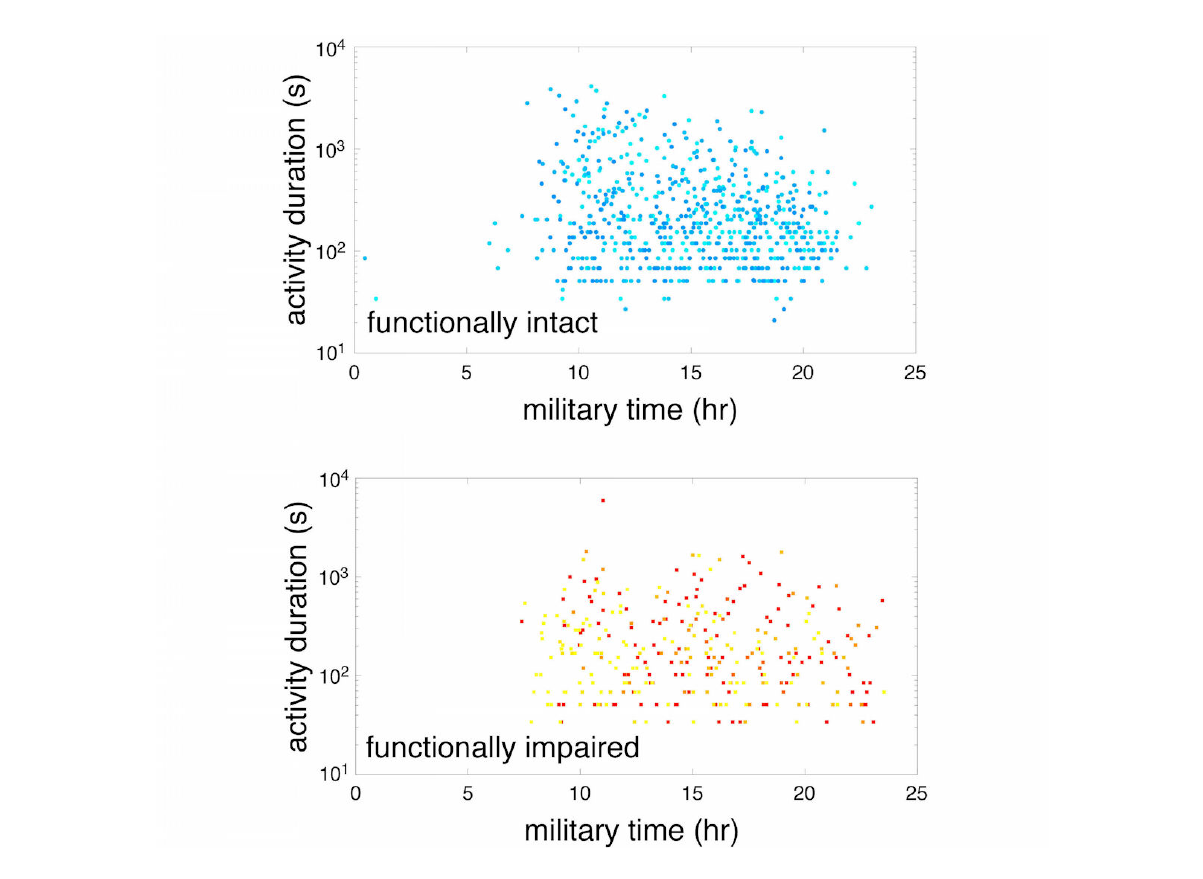
Figure 3. Semilog (y axis) of activity duration versus start time of that particular activity bout (x axis) in functionally intact individuals (upper) and functionally impaired individuals (lower). Each point represents a specific activity bout and each color corresponds to a specific participant ("cool" or "warm"